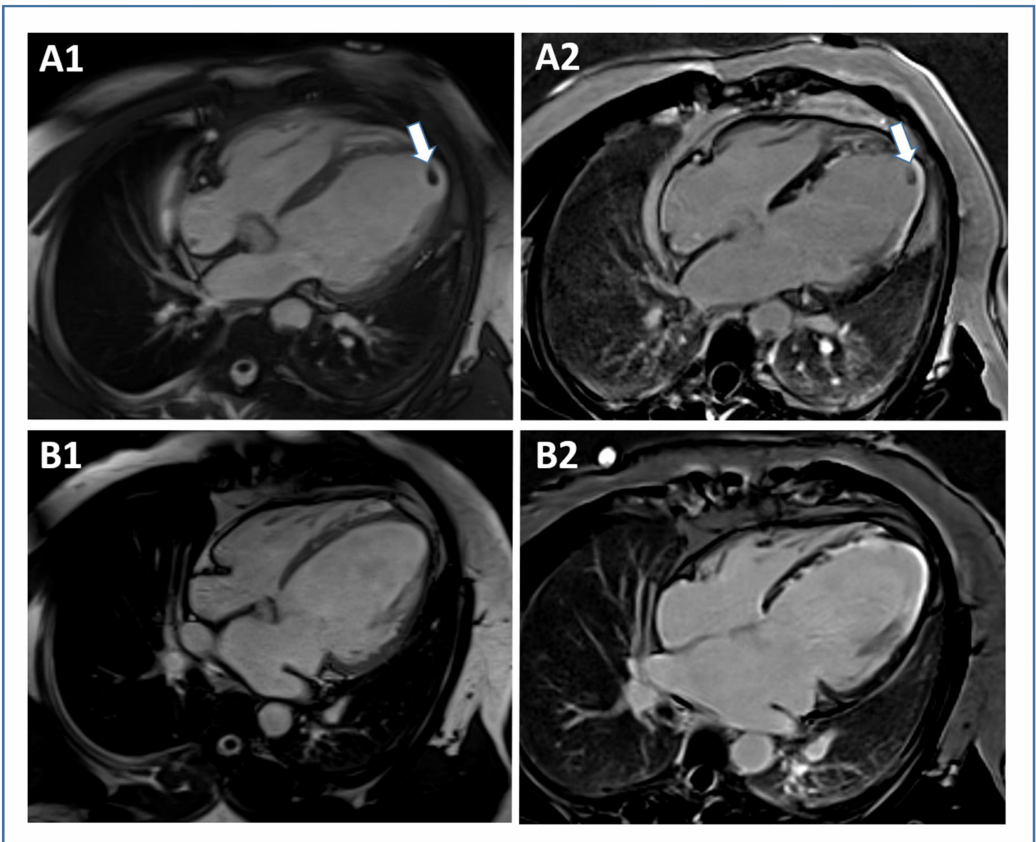
Figure 5. Left ventricular thrombus detection by cardiac magnetic resonance. Two representative patients with anterior STEMI: “Patient A” (first line) with left ventricular thrombus (white arrow, ( A1 , A2 )); and “Patient B” without thrombus ( B1 , B2 ). Abbreviations: STEMI, ST-elevation myocardial